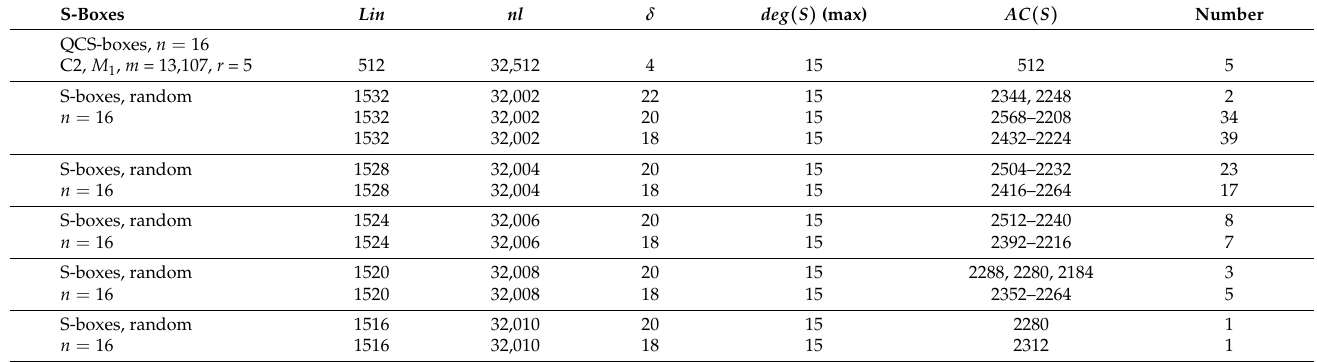
Table 6. Test evaluation between bijective 16-bit QCS-boxes and randomly generated 16-bit S-boxes